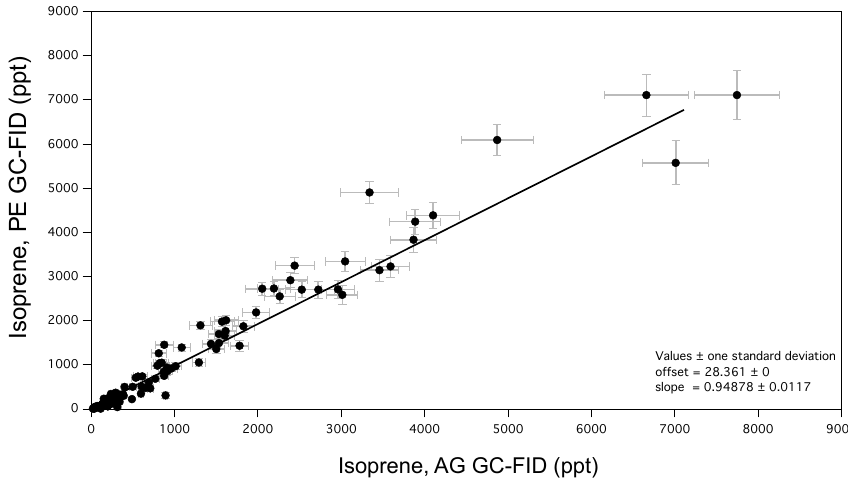
Fig. 1. Correlation between isoprene mixing ratios in ambient air quantified by the independent Agilent (AG) and Perkin Elmer (PE) GC- FID instruments at the Bukit Atur GAW station in April 2008. Note only mixing ratios derived from simultaneous measurements (sampling periods within ± 5min) were used for this